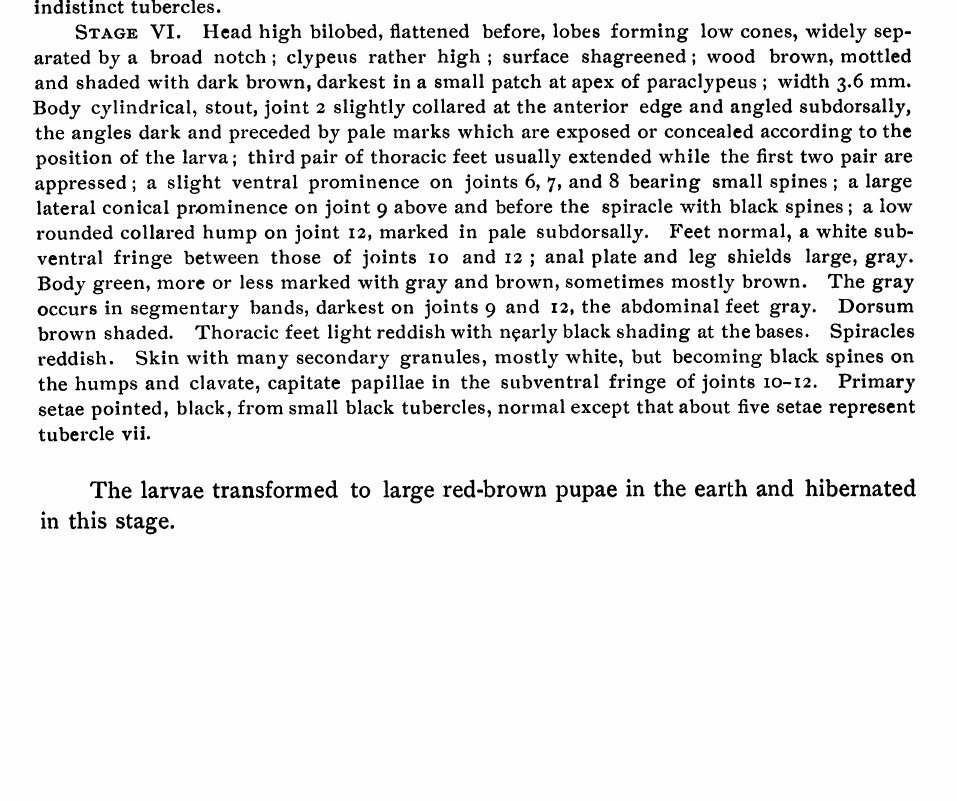
STAGE II. Head rounded bilobed, squarish, a depression at apex of clypeus width .5 ram. Body moderately robust, normal, subventral fold rather prominent. Greenish and brown, mottled, nearly all green along the subventral fold, venter and dorsum more brown, especially about the feet. Head reddish brown, reticulate in lighter, ocelli black; feet dark. Anal feet and shield reddish, resembling the head. No plates tubercles obsolete. STAGE III. Head high bilobed, flat before, lobes rounded, projecting above the dorsum, pale yellowish sordid, thickly mottled with brown;width .8 ram. Body rather robust normal, venter somewhat flattened. Pale yellowish, this color showing on subventral fold but elsewhere thickly mottled in dead leat brown. Thoracic feet pale greenish, foot of joint Io dark brown outwardly. Anal shield lighter brown, resembling the head. A white patch on each side of clypeus and across it more faintly. STAGE IV. Head high bilobed, flat before, lobes subconic, projecting rather widely; brown, mottled in white before and also a little with smoky, a blackish arc at apex of cly- peus; sides less strongly mottled; width x. 3 mm. Body rather short, moderately robust, normal. Smooth green, overlaid with a brown shade, most distinct at the contracted ends; joints -4 and Io-I3 slightly shining, without defined markings, only the faintest traces of pale lines showing at the ends. STAGE V. Head high bilobed as before, red-brown, mottled with white, which forms curved streaks on the faces of the lobes vertex behind and sides at neck dark shaded; width 2 ram. Body cylindrical with a process on joint 9 bearing tubercle iii, rounded and cushion- like; no cervical shield, anal plate triangular, anal foot plates large, elongate, with stout anal prongs.. Light red-brown to dark sordid brown, irregularly shaded, darker on the anterior halves of the segments, darkest ventrally. Feet dark at base. Setae short, stiff, black, from indistinct tubercles. STAG VI. Head high bilobed, flattened before, lobes forming low cones, widely sep- arated by a broad notch; clypeus rather high; surface shagreened; wood brown, mottled and shaded with dark brown, darkest in a small patch at apex of paraclypeus width 3.6 ram. Body cylindrical, stout, joint slightly collared at the anterior edge and angled subdorsally, the angles dark and preceded by pale marks which are exposed or concealed according to the position of the larva; third pair of thoracic feet usually extended while the first two pair are appressed a slight ventral prominence on joints 6, 7, and 8 bearing small spines; a large , lateral conical prominence on joint 9 above and before the spiracle with black spines; a low marked in pale subdorsally. Feet normal, a white sub- rounded collared hump on joint ventral fringe between those of joints o and x; anal plate and leg shields large, gray. Body green, more or less marked with gray and brown, sometimes mostly brown. The gray occurs in segmentary bands, darkest on joints 9 and I, the abdominal feet gray. Dorsum brown shaded. Thoracic feet light reddish with nearly black shading at the bases. Spiracles reddish. Skin with many secondary granules, mostly white, but becoming black spines on the humps and clavate, capitate papillae in the subventral fringe of joints o-2. Primary setae pointed, black, from small black tubercles, normal except that about five setae represent tubercle